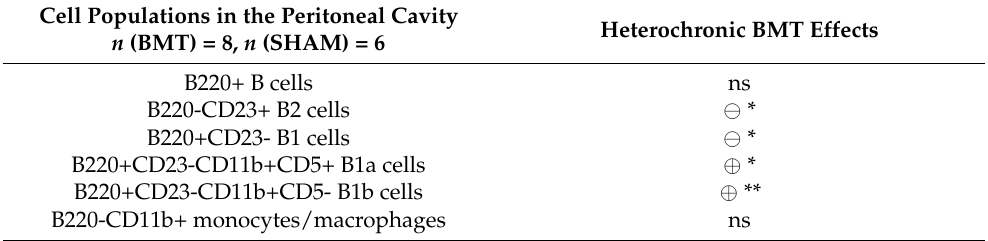
Table 3. Immunophenotyping by flow cytometry (cell source: peritoneal cavity). Cell Populations in the Peritoneal Cavity